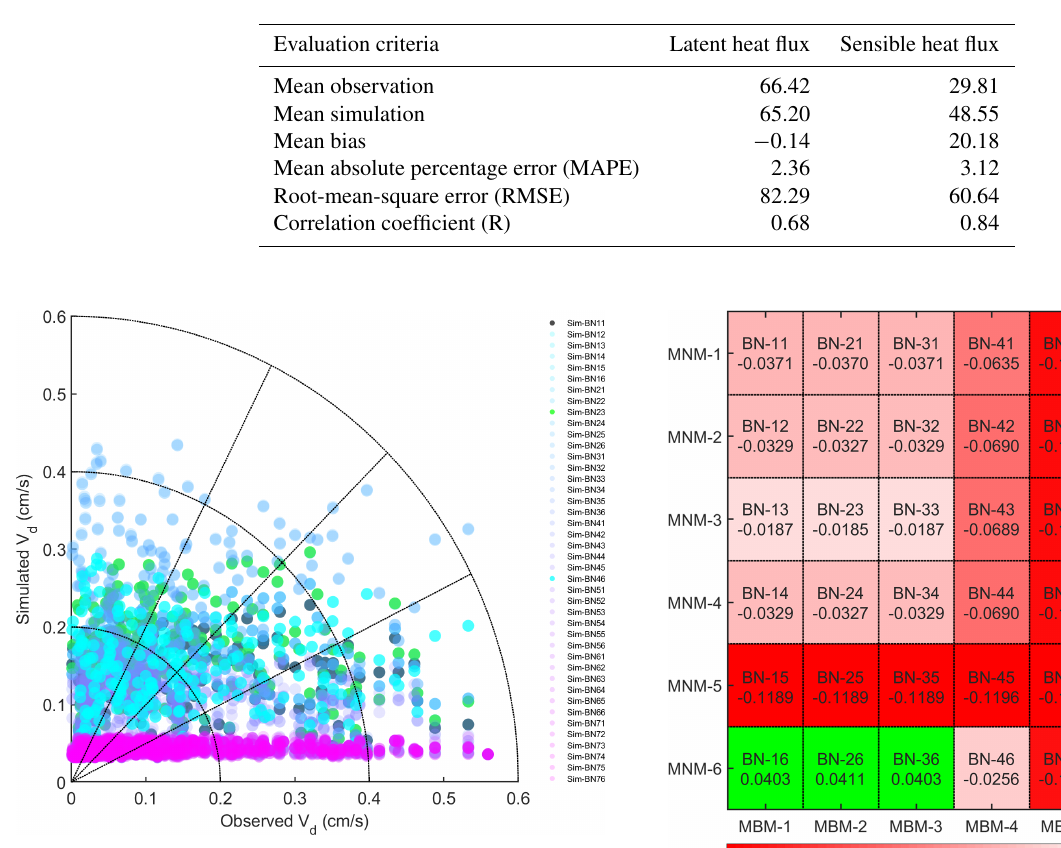
Table 3. Statistical results of original simulated values and observed values.